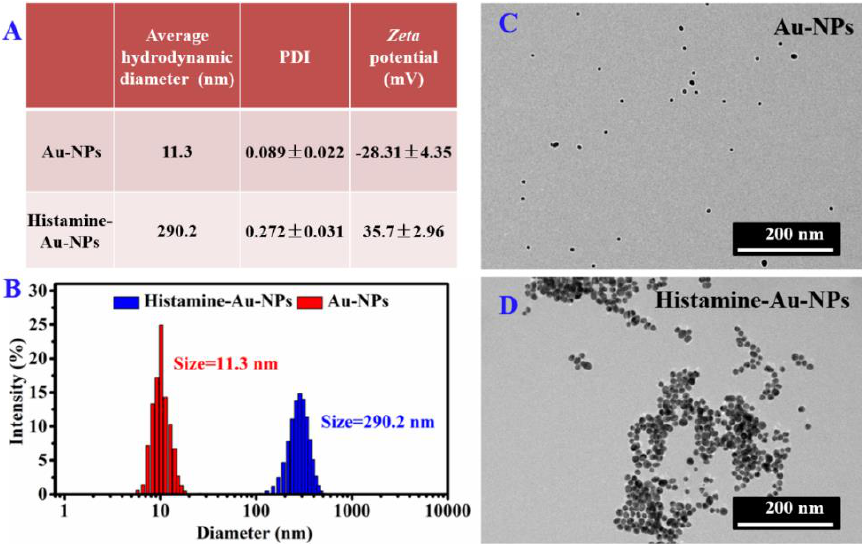
Figure 2. ( A ) Average hydrodynamic diameter, polydispersity index (PDI) and zeta potential information, ( B ) Dynamic Light Scattering (DLS), and ( C – D ) TEM images of Au-NPs and the aggregation of histamine-Au-NPs.